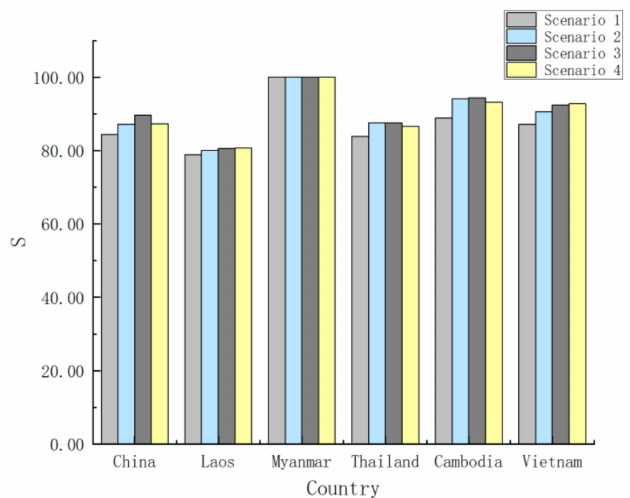
Figure 4. Satisfaction degree of each BC under di ff erent preference scenarios.